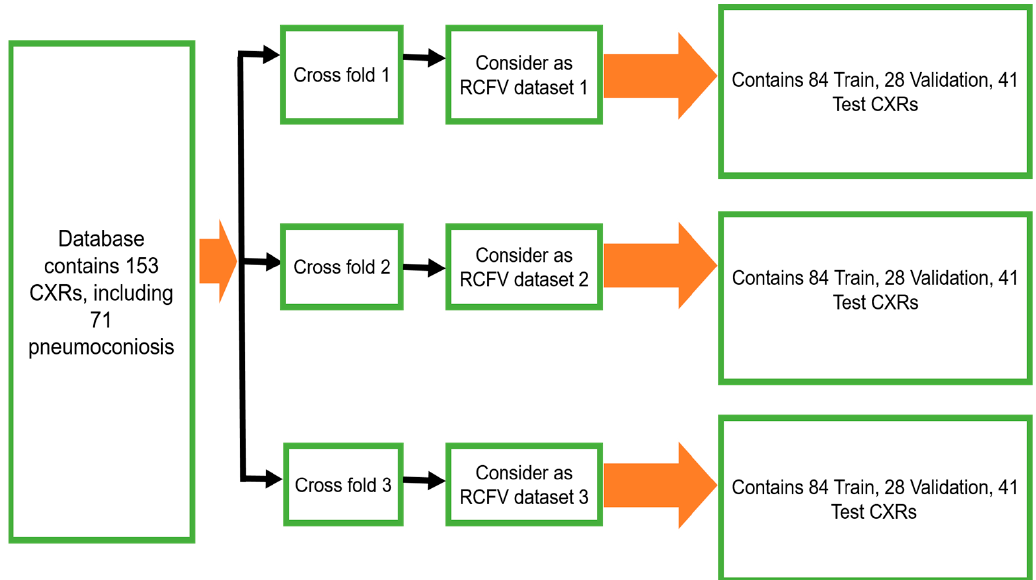
Figure 2. Three RCFVs of our proposed dataset.